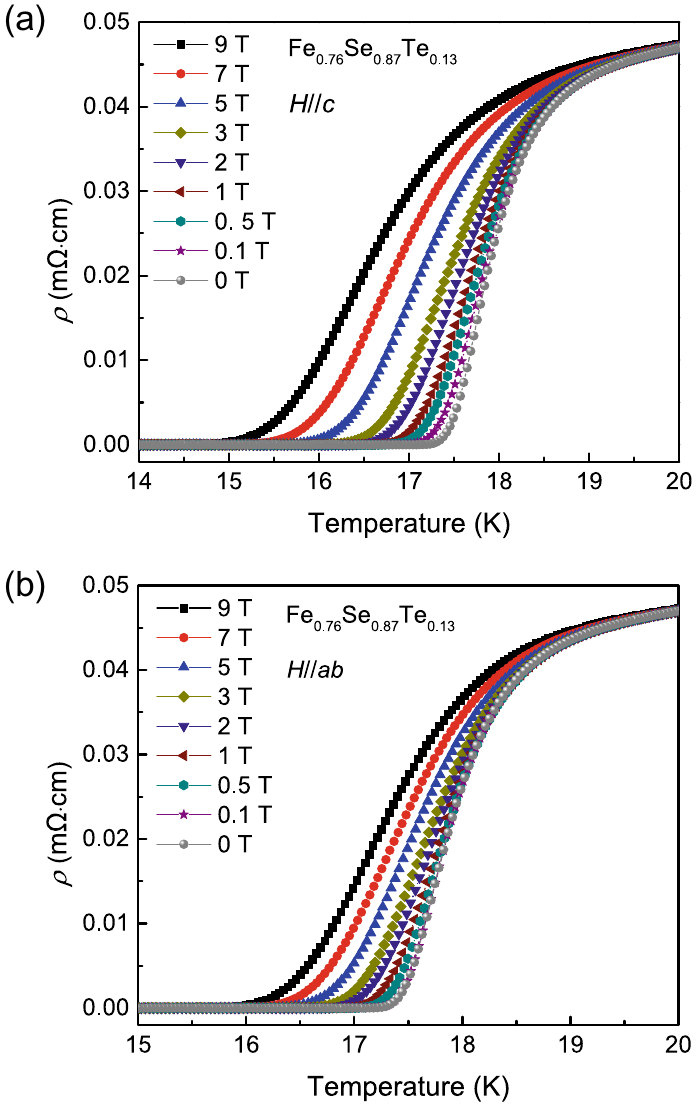
Figure 3. Temperature dependence of resistivity near T c in various magnetic fields for Fe 0.76 Se 0.87 Te 0.13 thin film. ( a ) H // c and ( b ) H // ab